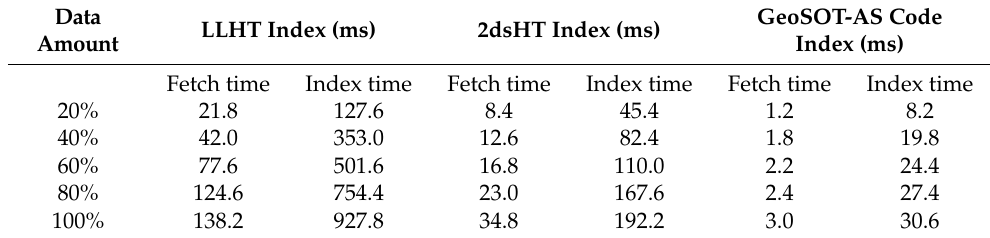
Table 10. Comparison table of index query time under different